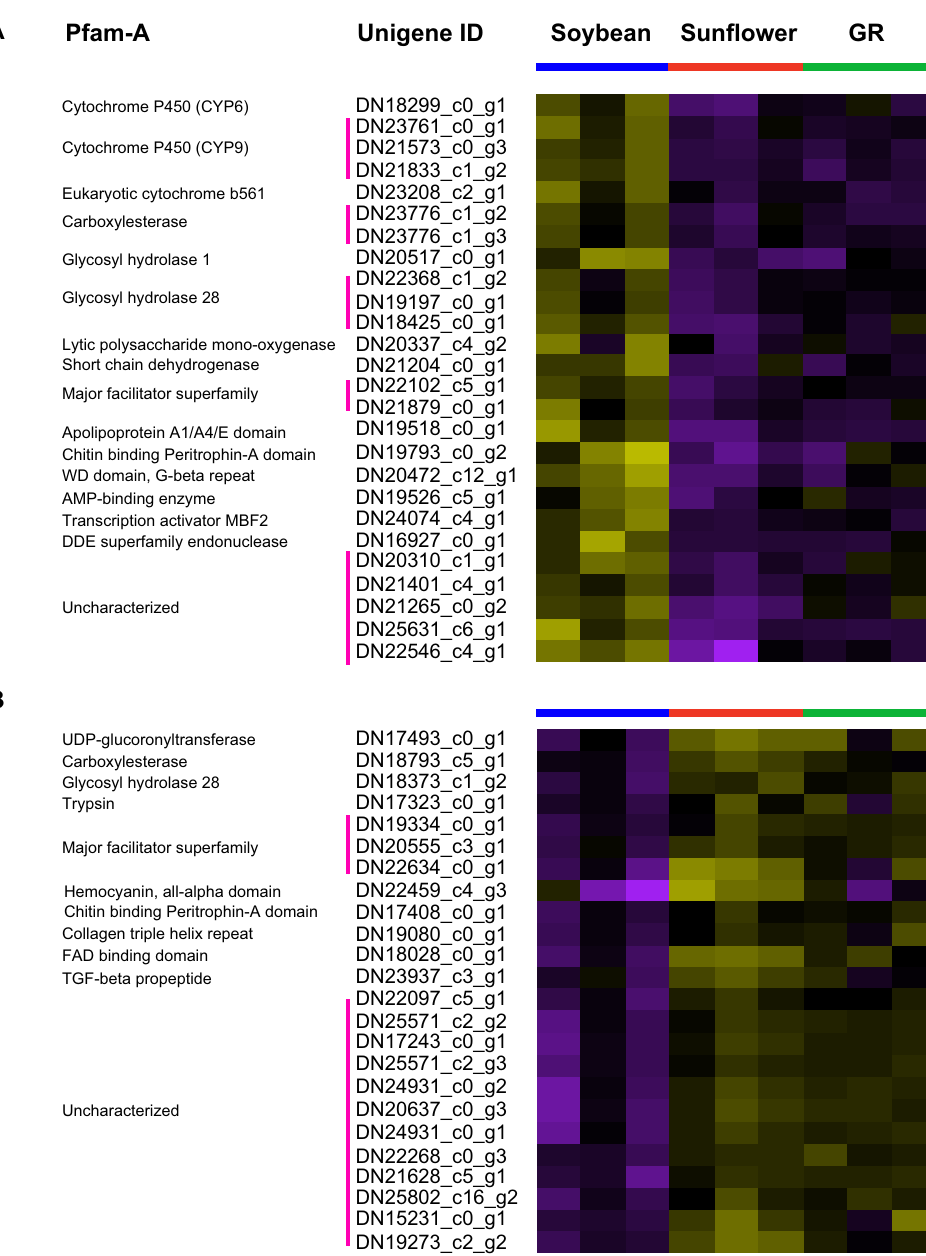
Figure 7. Heatmaps of unigenes expressed at ( A ) higher and ( B ) lower levels in larvae fed soybean compared to sunflower and giant ragweed by K-means analyses. Each row represents a separate unigene. Yellow and purple indicate high and low expression levels, respectively (Fold change > ± 1.5, False Discovery Rate < 0.05). Pfam-A = Protein family-A domain; CYP = Cytochrome P450; CarE = Carboxylesterase; MFS = Major facilitator superfamily; WD = Tryptophan-aspartic acid dipeptide; AMP = Adenosine monophosphate; MBF2 = Multiprotein-bridging factor 2; DDE = Aspartic acid-Aspartic acid-Glutamic acid motif; UGT = UDP- glucuronosyl-transferase; FAD = Flavin adenine dinucleotide; TGF = Transforming growth